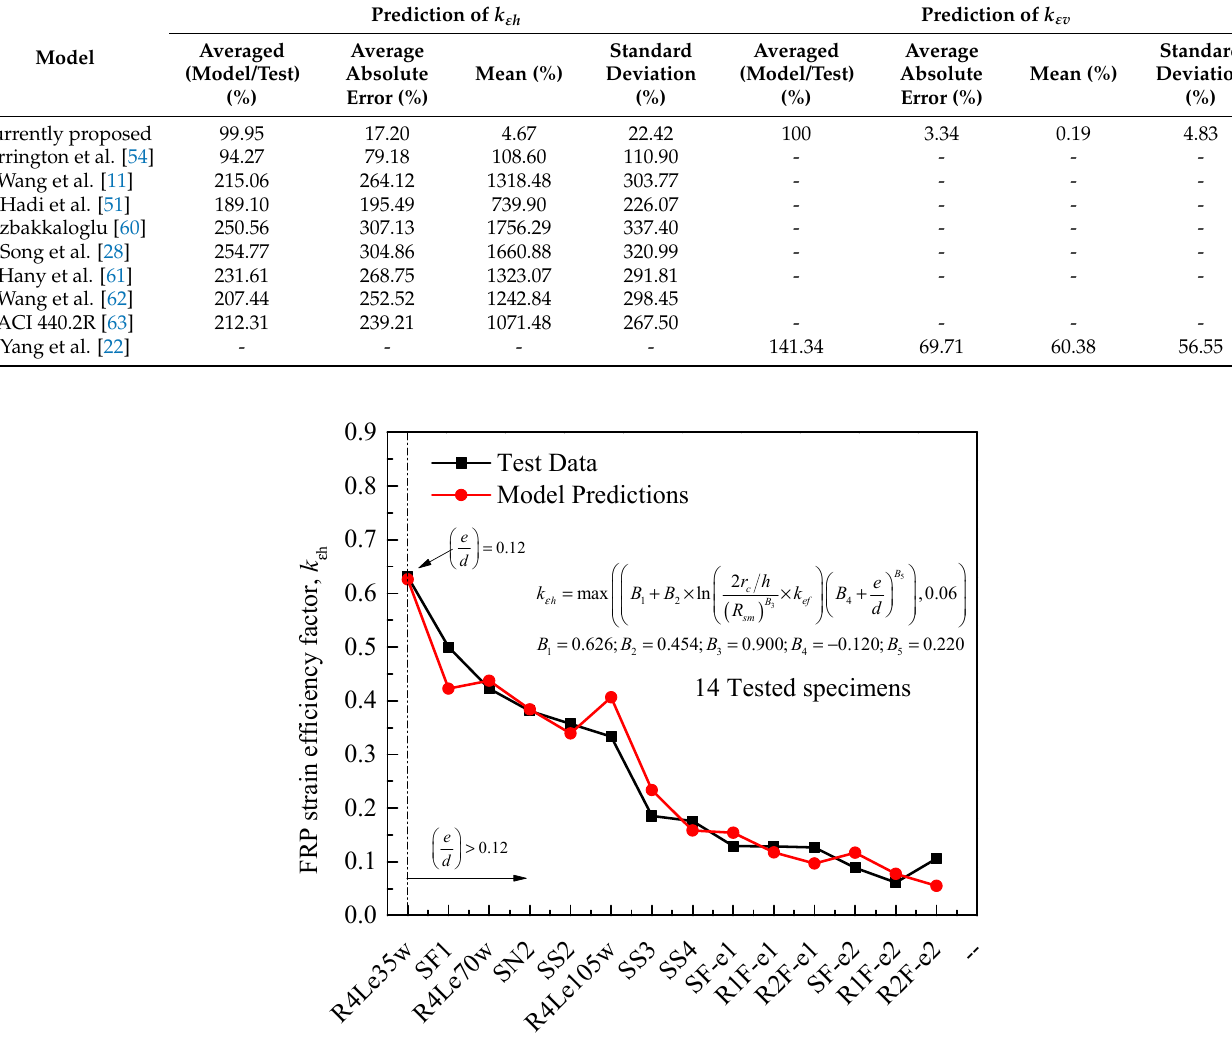
Figure 5. Comparison between experimental and predicted hoop FRP strain efficiency factors.